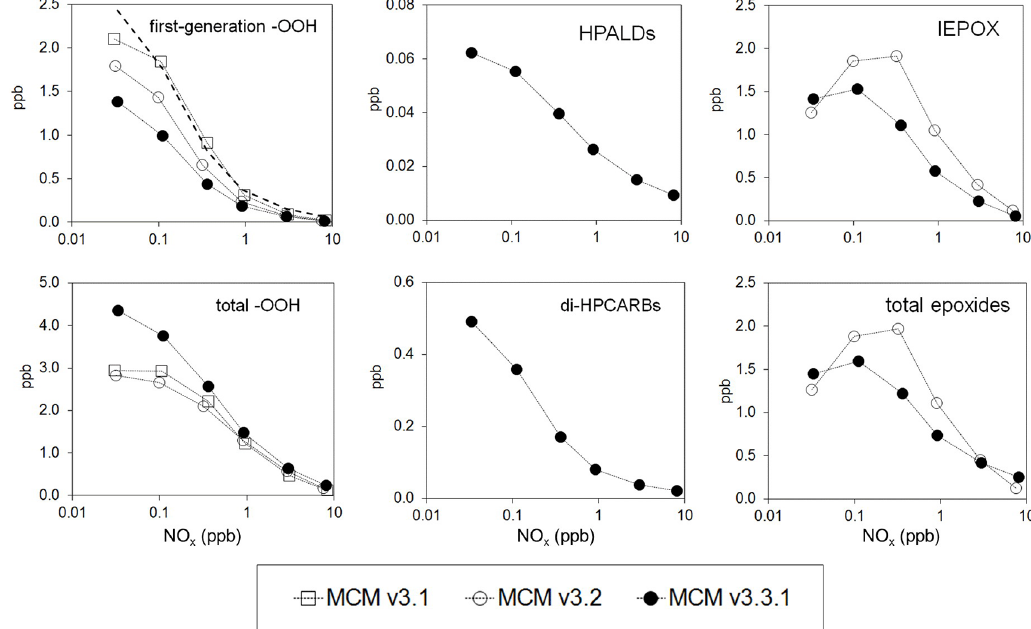
Figure 14. Comparison of the performances of MCM v3.1, MCM v3.2 and MCM v3.3.1, showing the NO x dependence of the daylight- averaged mixing ratios of selected hydroperoxides and epoxides. The first-generation hydroperoxides are specifically those formed from the reactions of HO 2 with first-generation peroxy radicals (denoted “ISOPO2” in Fig. 10). HPALDs are C5HPALD1 and C5HPALD2; di- HPCARBs are DHPMEK and DHPMPAL; and IEPOX includes the epoxydiols, IEPOXA, IEPOXB and IEPOXC. The heavy broken line in the “first-generation –OOH” panel shows the effect of including HPALDs and di-HPCARBs in the MCM v3.3.1